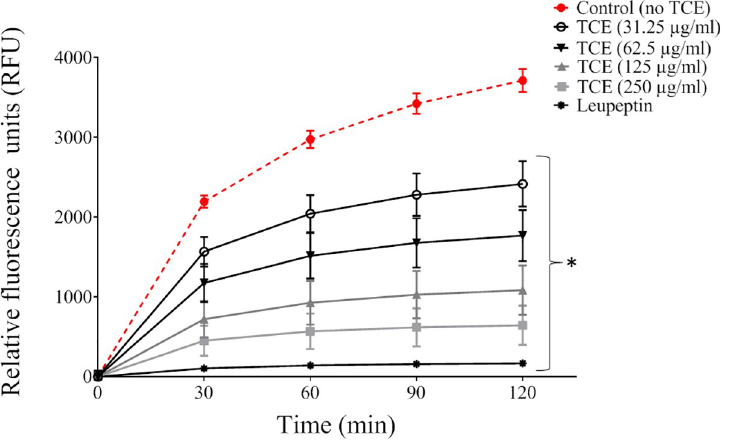
Fig 3. Effect of the Tart Cherry Extract (TCE) on collagen degradation by P . gingivalis . Collagen degradation was assayed using a fluorescent substrate. Results are expressed as the means ± SD of triplicate assays.